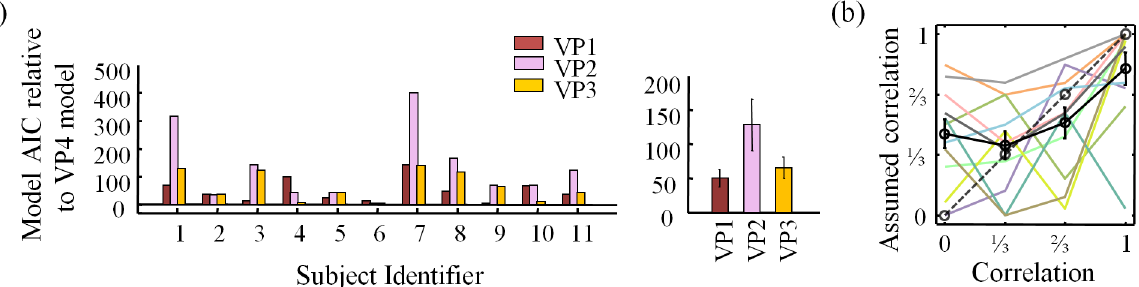
Fig 6. AIC model comparison of VP models for observer ’ s assumption about ρ and parameter estimates of VP4 model ρ assumed . (a) Shown are AIC differences of VP models relative to VP4 (most general) model for each subject (left) and averaged across subjects (right). (b) ML estimates of ρ assumed from the VP4 model for each subject (colors) and averaged (black). BIC results are consistent (see S1b Fig).